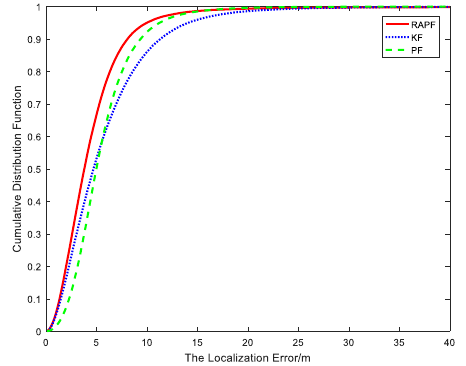
Figure 13. The CDF versus the localization error.